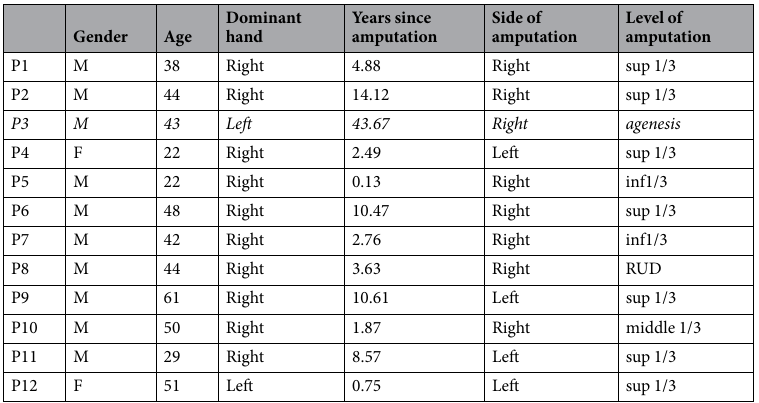
Table 1. Clinical characteristics of the patients. P = patient, M = male, F = female, sup 1/3 = superior third of forearm, inf 1/3 = inferior third of forearm, RUD = Radio-ulnar disarticulation. Healthy subjects – mean age: 41.4 years (min = 23–max = 68), Sex ratio M/F: 5.Patient P3 couldn’t be analysed properly because of “out of range” overestimations within the experiments.